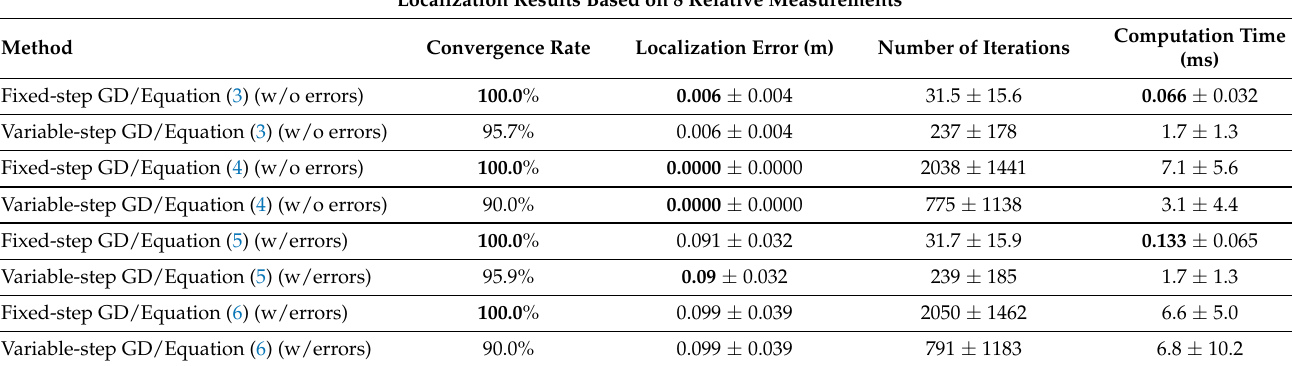
Table 6. Comparative localization results using the different formulations of the estimation problem based on 8 relative measurements, with and without taking into account uncertainty